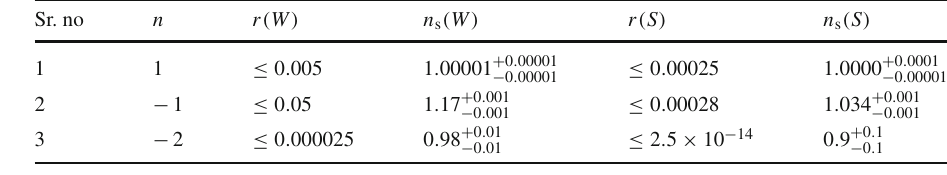
Table 5 MCG weak and strong dissipative regime with negative quadratic and quartic potential